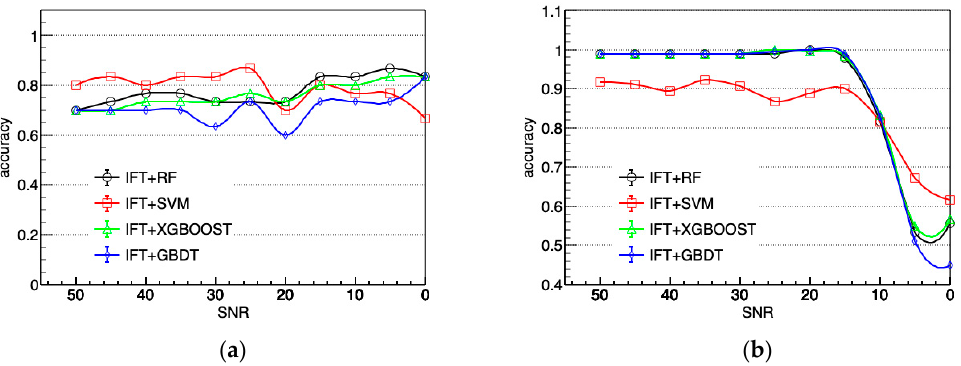
Figure 4. The results of a noise sensitivity analysis on two datasets, which are OliveOil dataset ( a ) and ShapeletSim dataset ( b ), respectively. IFT: Interval Feature Transformation; RF: Random Forest; SVM: Support Vector Machine; XGBOOST: eXtreme Gradient Boosting; GBDT: Gradient Tree Boosting; SNR: Signal Noise Ratio.